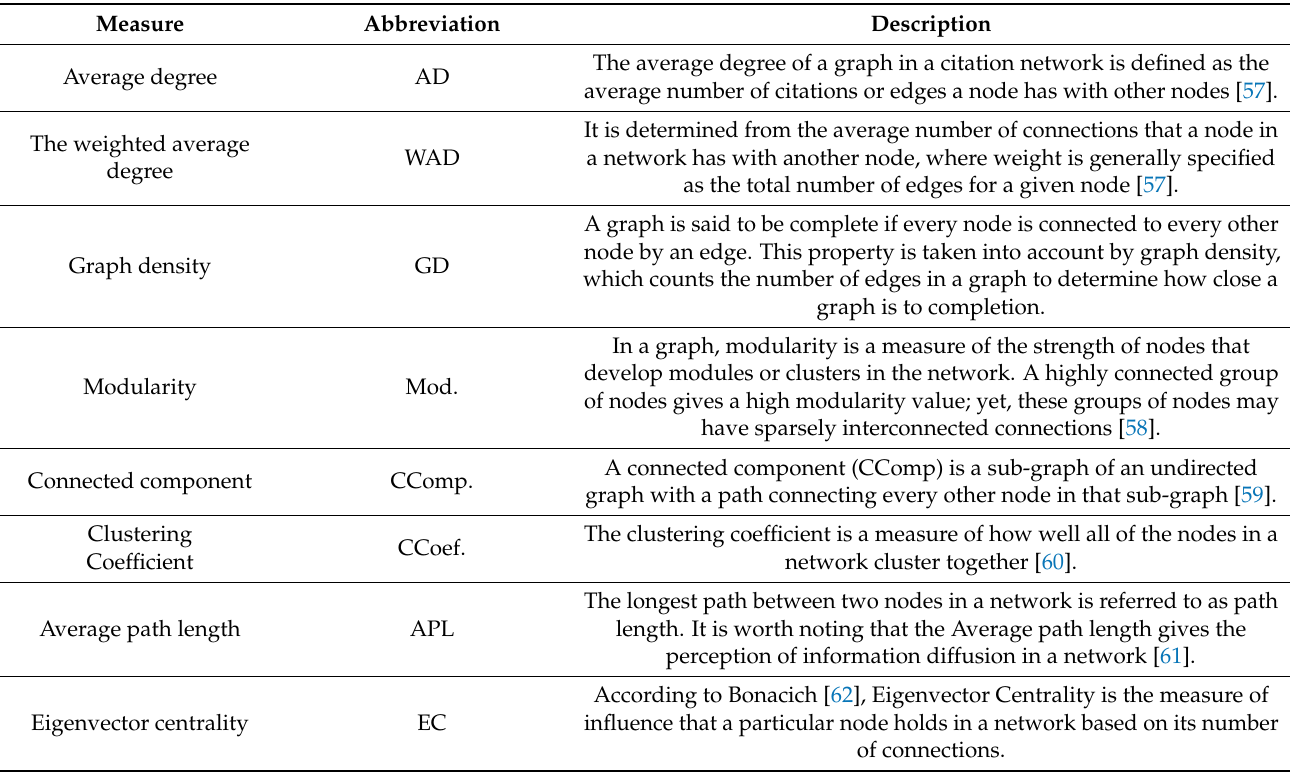
Table 2. Network-level properties along with their abbreviations and